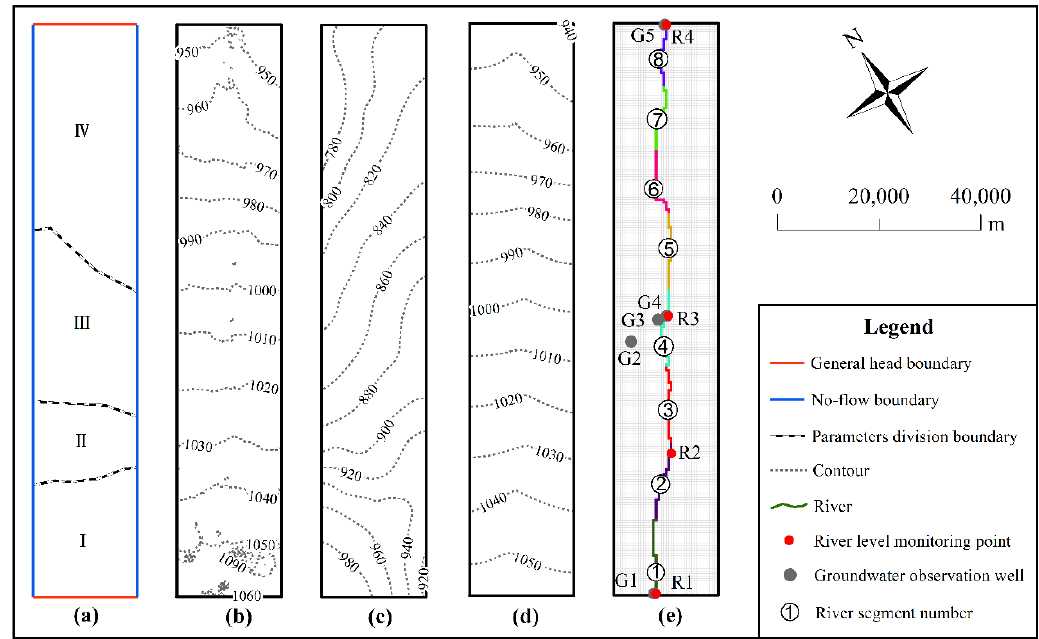
Figure 2. Model setup: ( a ) parameter division; ( b ) land surface elevation; ( c ) bottom elevation of the aquifer; ( d ) initial water levels; and ( e ) river segment division and monitoring sites.